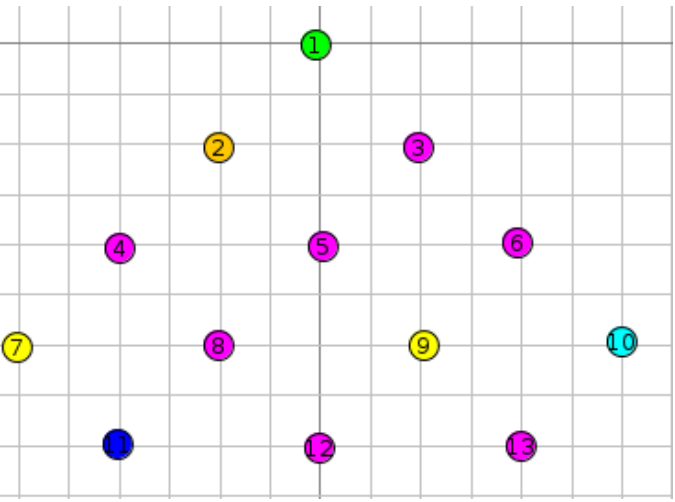
Figure 9. Full flooding attack detection, simulation topology. Node 1 is the central IDS. Nodes 7 and 9 are the IDS detectors. Node 2 is the DIS attacker. Node 10 is the Hello flood attacker. Node 11 is the DAO insider attacker. The rest of the nodes are dummy